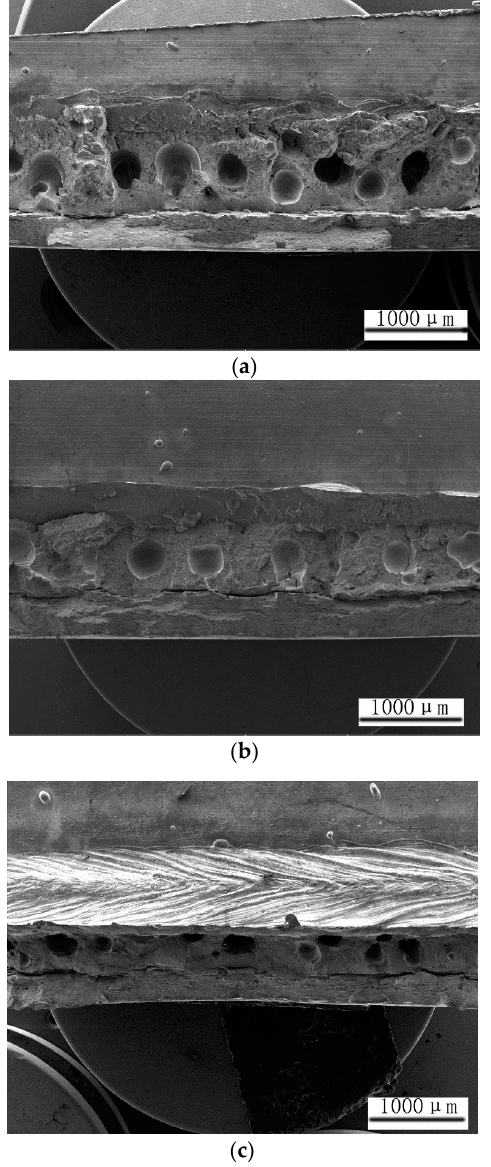
Figure 6. Macro morphology of tensile fracture of weld. ( a ) sample 1, ( b ) sample 2, ( c ) sample 3.